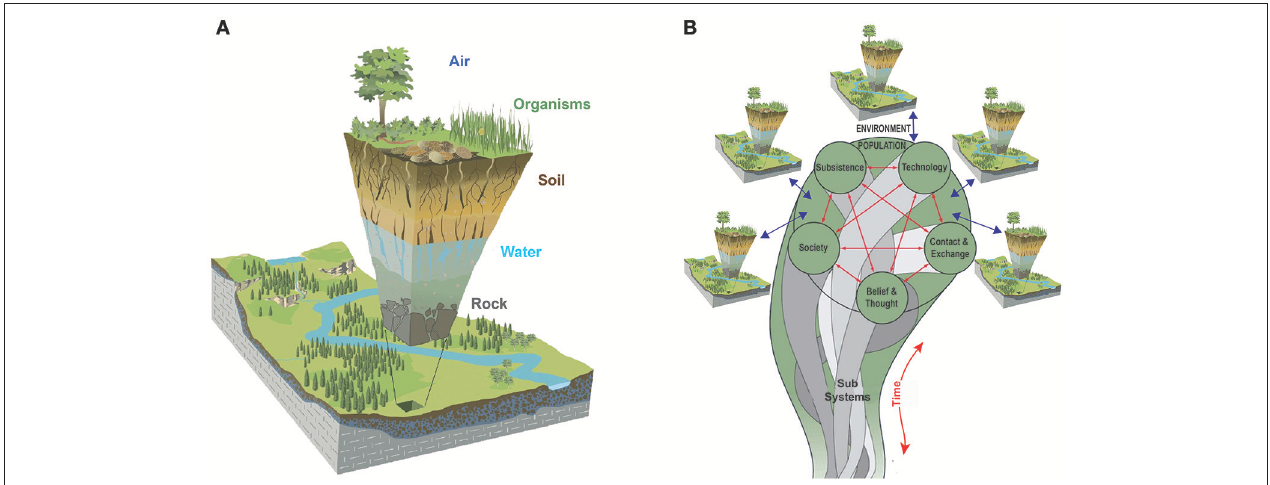
FIGURE 1 | Theoretical frames of reference. (A) An illustration showing the CZ and its components: air, organisms, soil, water, and rock (modified from Chorover et al., 2007 ), artwork by R. Kinlimann. (B) An illustration showing the interrelated sub-systems of human social systems, as well as the interactions between these systems and local hCZ’s (modified from Renfrew and Bahn,